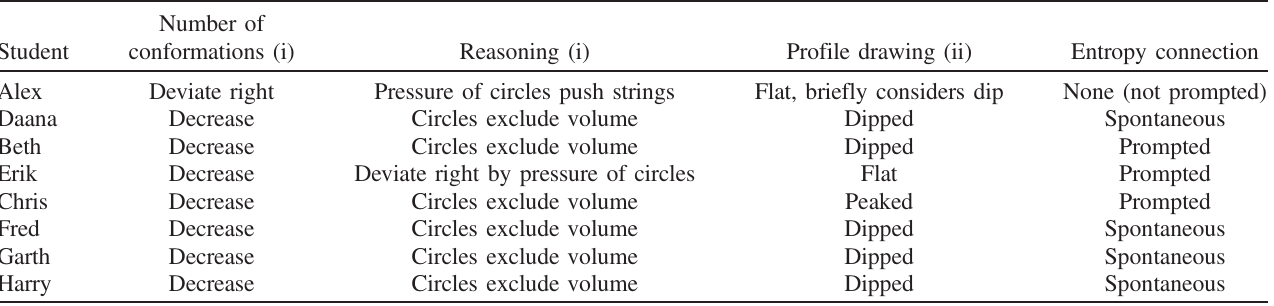
TABLE V. Summary of graduate student responses to part E of the strings question. Lower case roman numerals in parentheses on title row refer to prompts in Fig. 3. For example, sketches of the flat and dipped profiles drawn by students see Fig. 5.